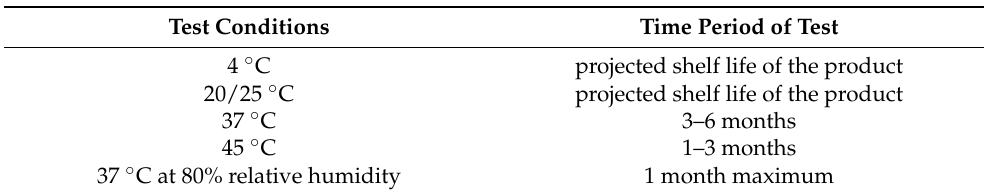
Table 1. Suggested storage conditions for the accelerated stability test by the International Federation of the Societies of Cosmetic Chemists (IFSCC)